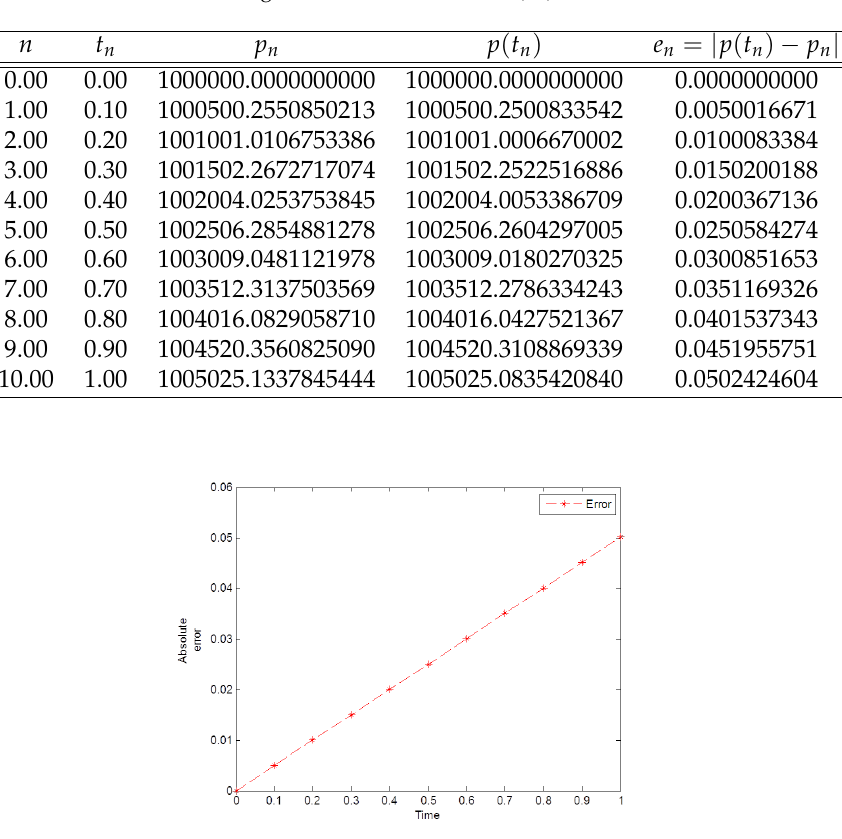
Table 4. Table 4. The results generated via the scheme (40) and the exact solution